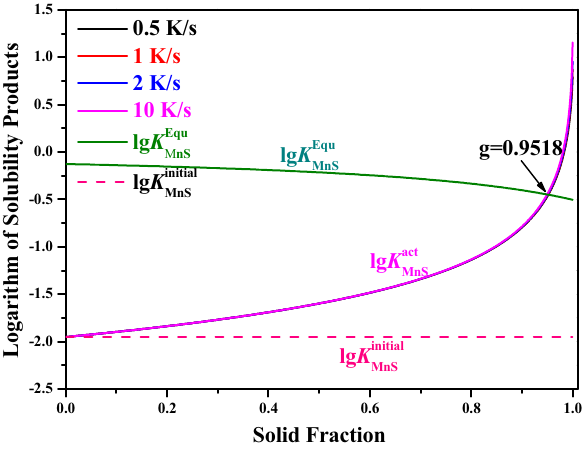
Figure 2: Comparisons of the equilibrium solubility product with the actual values at different cooling rates ( the initial solubility product is also given as reference )